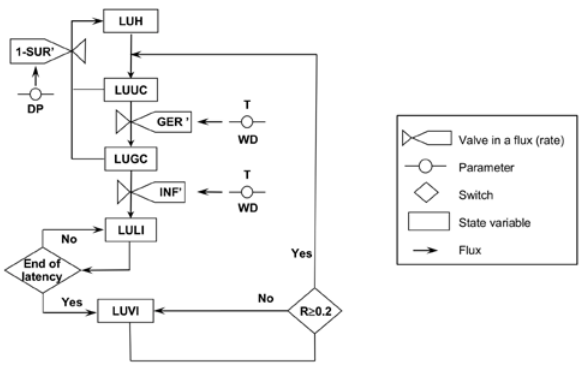
Figure 1. Relational diagram of the model simulating infec- tion of loquat fruit by Fusicladium eriobotryae , adapted from González-Domínguez et al.